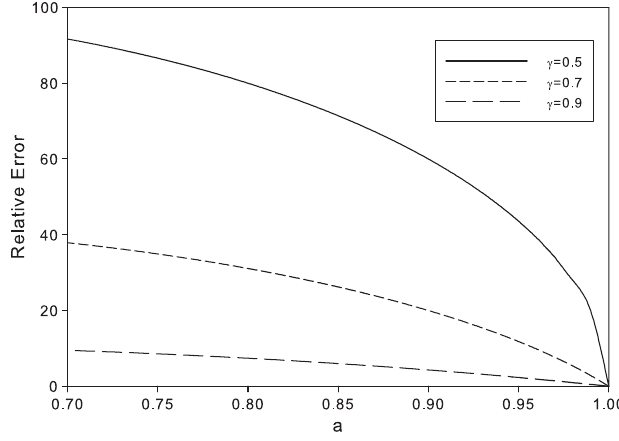
FIG. 8. Relative error vs a . The relative error 100% (cid:6) Þ =(cid:1) vs a where (cid:1) ð (cid:1) (cid:1) (cid:1) þ þ is the model analysis prediction and (cid:1) is the exact